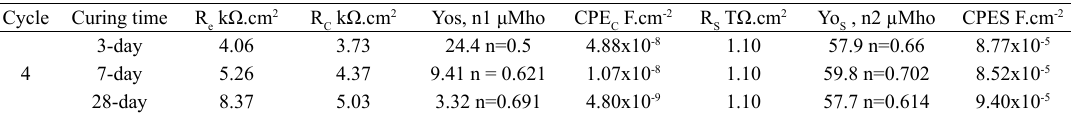
of the equivalent circuit components for samples cured at o